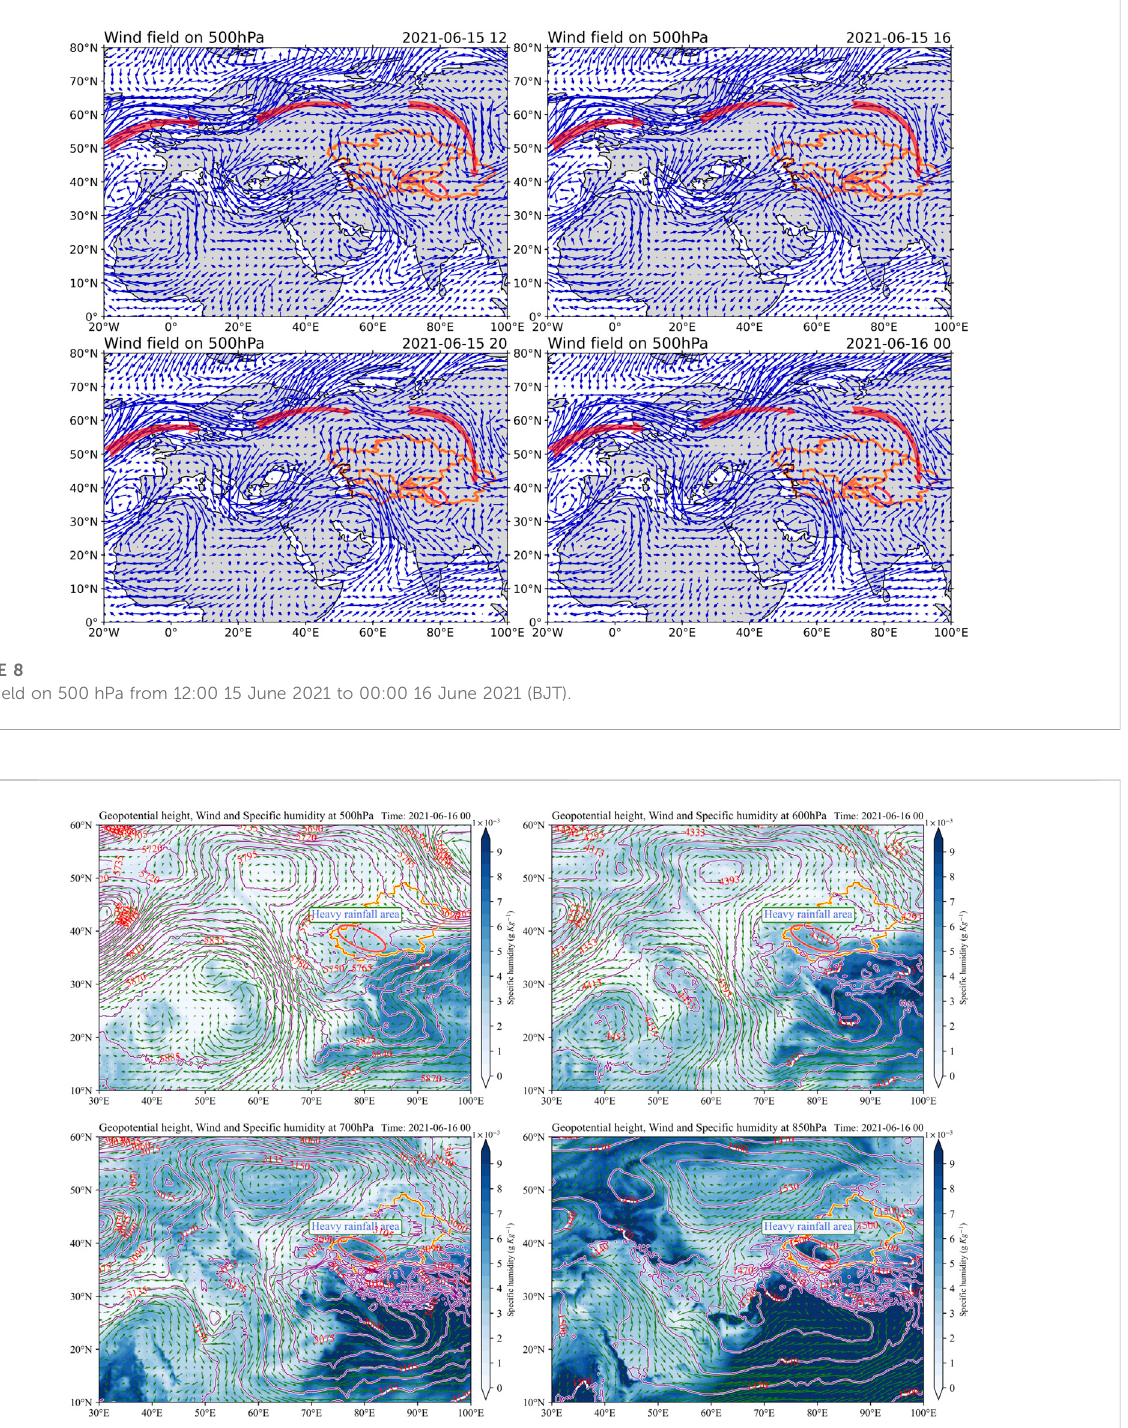
FIGURE 9 Geopotential Height, Wind fi eld and speci fi c humidity on 500 hPa, 600 hPa, 700 hPa and 850 hPa pressure level at 00:00 16 June 2021